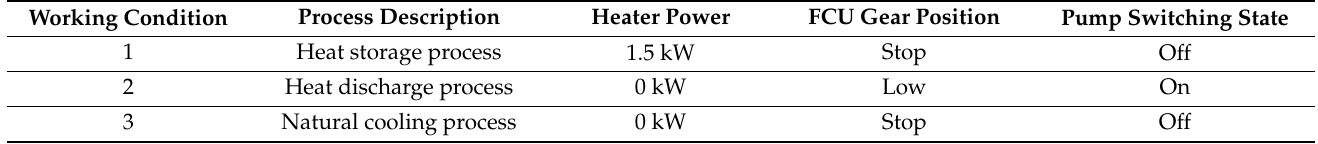
Table 2. Working condition